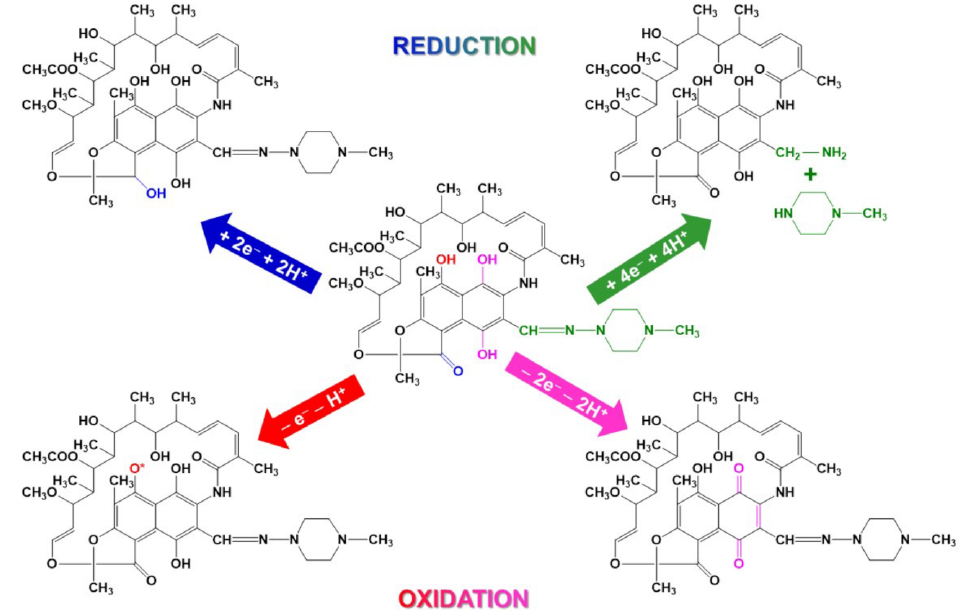
Figure 3. RIF electroactive sites and possible electrode reactions.